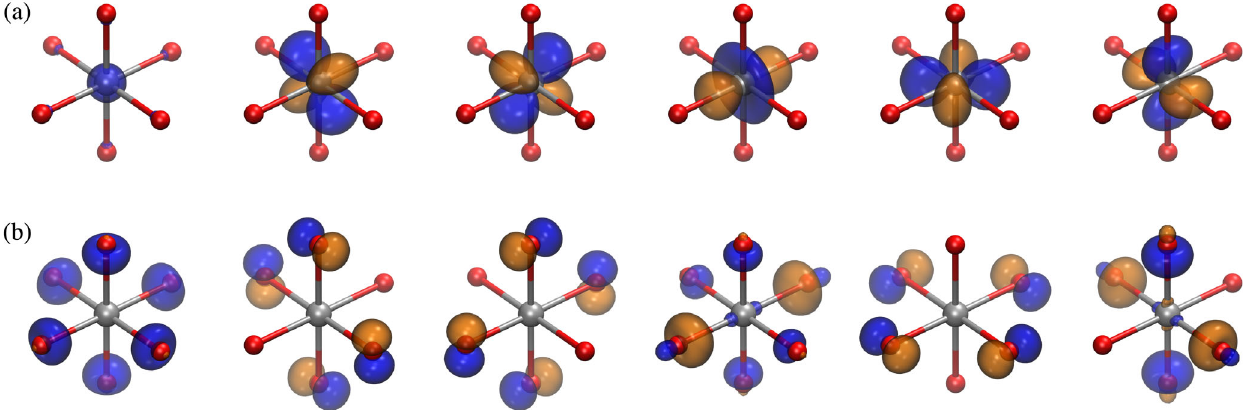
FIG. 8. (a),(b) Isosurface plots of fragment and DMET bath orbitals of the embedding of Ti in SrTiO 6 . Depicted is only a single TiO 6 octahedron with Ti in silver and O in red. An isovalue of (cid:3) 0 . 1 is used for all plots. (a) 4 s and 3 d intrinsic atomic orbitals of Ti. (b) Associated DMET bath